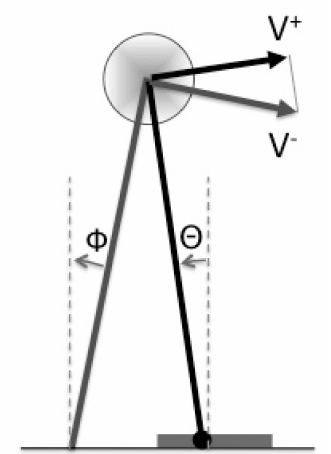
Figure 19. Modeling of the Foot Touchdown Phase.